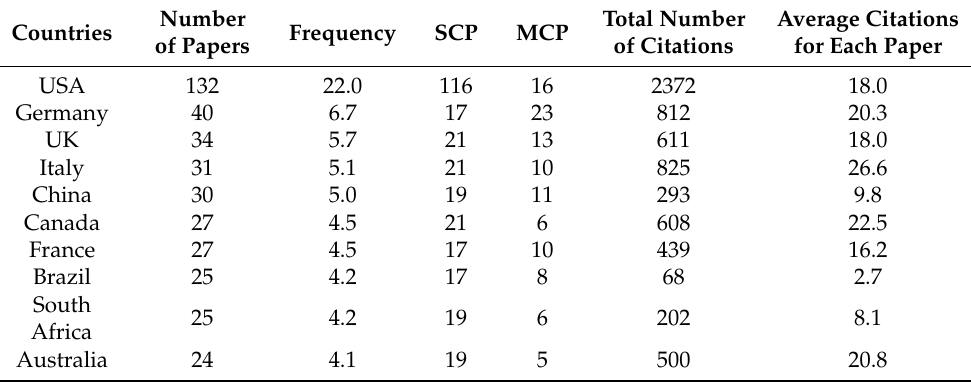
Table 1. Top 10 countries with the highest number of papers published on urban